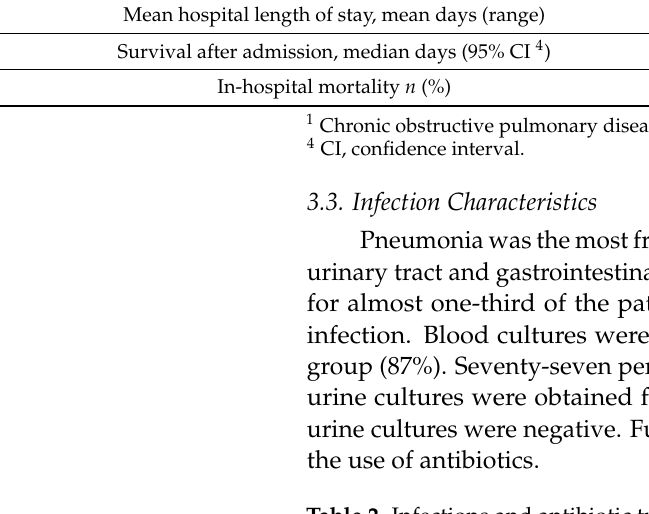
Table 2. Infections and antibiotic treatment characteristics. Infection group, n =